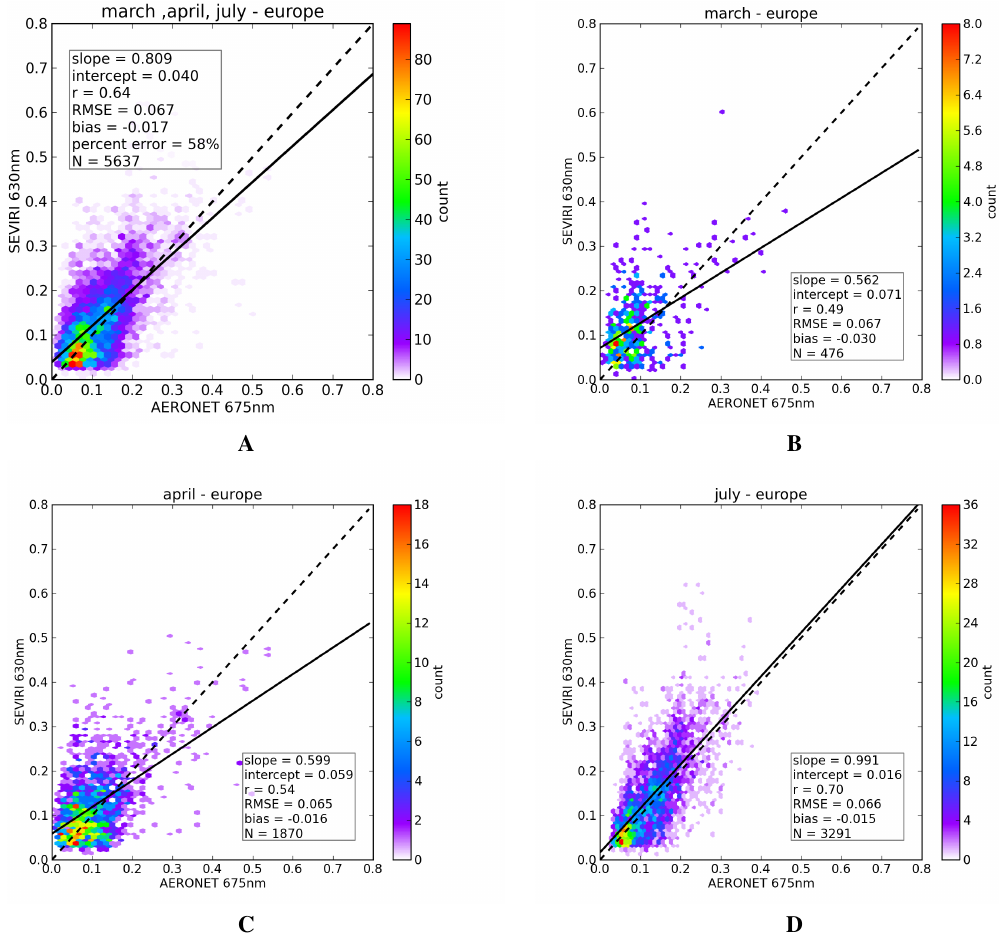
Fig. 4. Density graph of AOT SEVIRI against AERONET at 0.6µm for European stations for the 3 months: March, April and July 2006 (A) . The linear regression (black line) and the one-to-one curve (black dashed line) are plotted. The parameters of the linear regression are indicated on the graph. Individual validation for the 3 months separately are also plotted: March (B) , April (C) and July (D) .